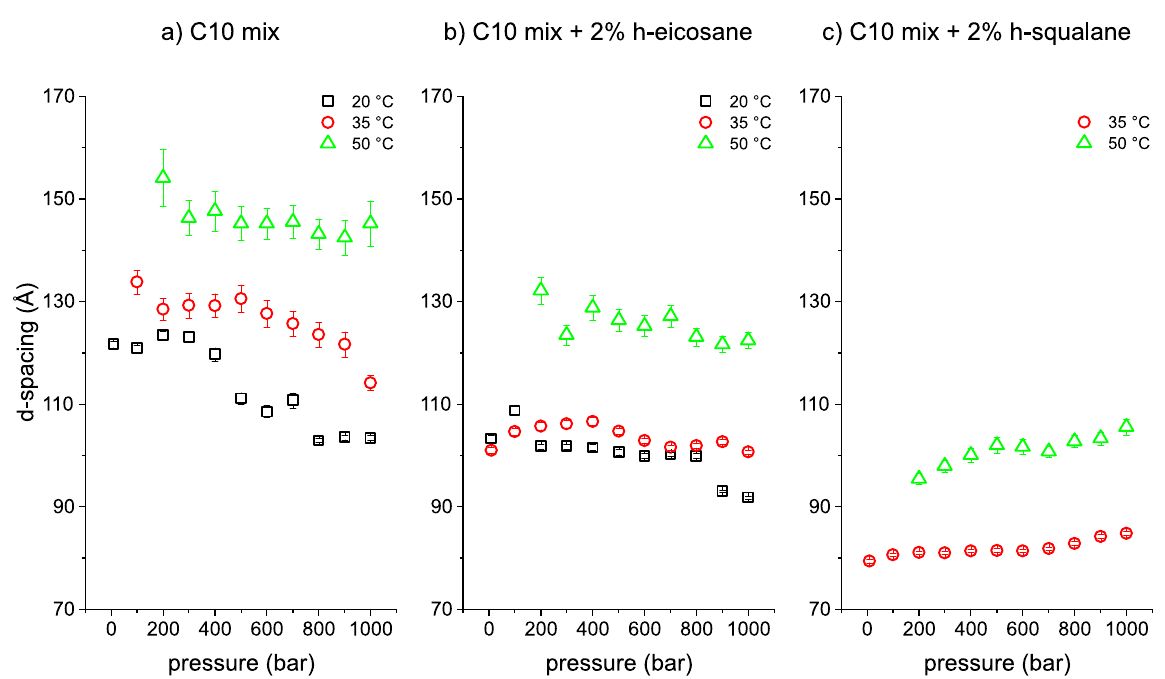
Fig. 3 d -spacing vs p – T . MLV d -spacing of the three measured samples at all T – p points where a lamellar correlation was fi tted. a C10 mix; b C10 mix + 2% h-eicosane; and c C10 mix + 2% h-squalane. The errors are calculated by propagation of the fi t parameter errors, as detailed in the main text.